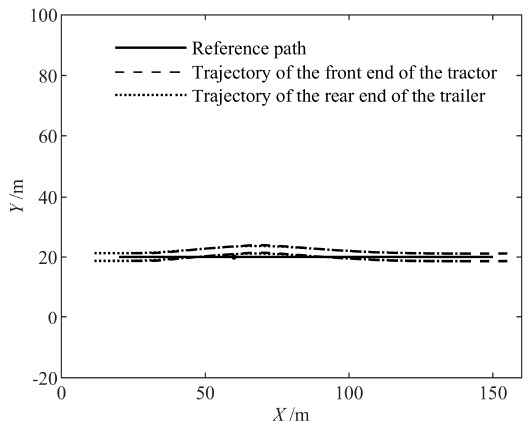
Figure 15. The trajectory of the obstacle avoidance controller based on the line model in the second group of simulations.